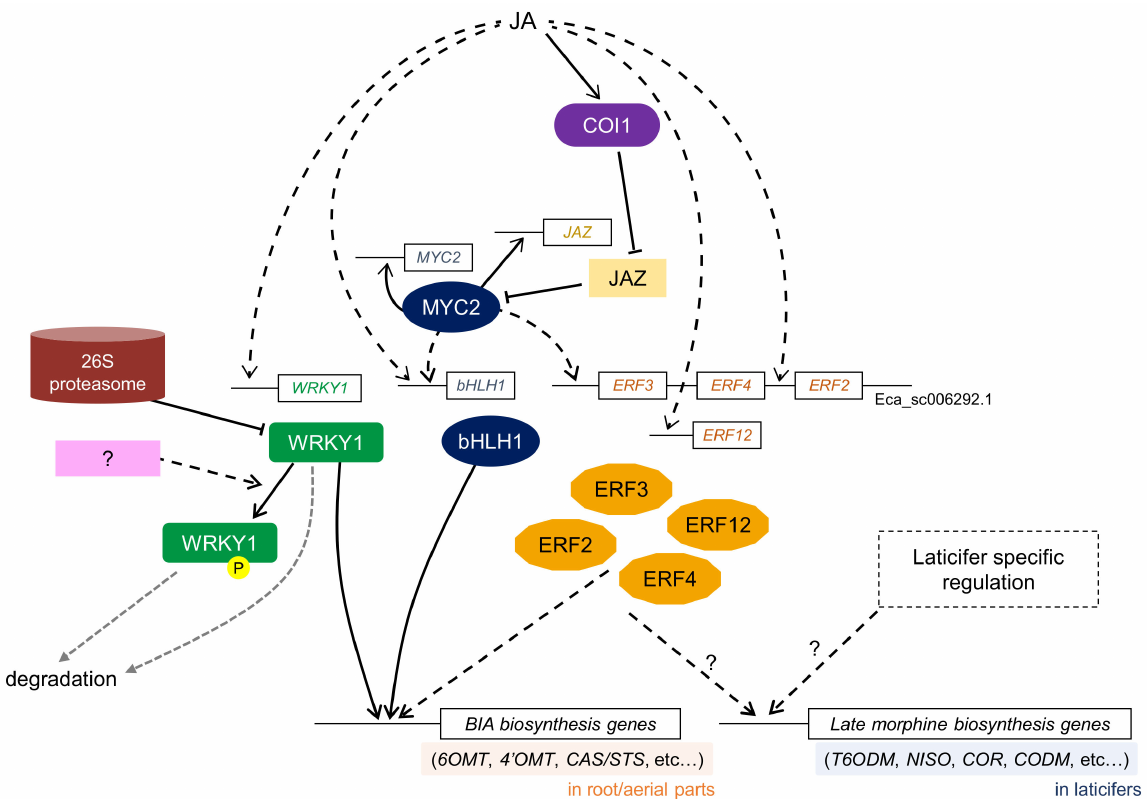
Figure 4. A simplified model of the transcriptional network of JA-signaling in BIA biosynthesis in C. japonica cultured cells and E. californica roots and cultured cells. Boxes with straight lines indicate regulator genes, including promoter regions. Black arrows and T-shaped lines indicate upregulation and inhibition, respectively. Broken lines show indirect or undetermined steps that are possibly involved in uncharacterized proteins or unidentified regulation. Gray dashed lines indicate degradation steps. Biosynthetic enzyme genes involved in late morphine pathway such as T6ODM , NISO , COR , and CODM might be controlled by laticifer-specific regulation, which remains to be determined. Since the functions of COI1, JAZ, and MYC2 proteins in BIA biosynthesis are not fully characterized, it is still unknown whether the expression of WRKY1 , bHLH1 , and several ERF genes is regulated by MYC2. Unphosphorylated WRKY1 is degraded by 26S proteasome, while unknown tyrosine kinase(s) and protease(s) might be involved in the phosphorylation and degradation of WRKY1, respectively, in C. japonica . BIA biosynthesis is regulated by several non-MYC2-type bHLH TFs (CjbHLH1 in C. japonica and EcbHLH1-1/2 in E. californica ), while only bHLH1 is described here. ERF2 , ERF3 , and ERF4 genes are clustered in the same E. californica genome scaffold, Eca_sc006292.1. Abbreviations: BIA, Benzylisoquinoline alkaloid; CAS/STS, ( S )- canadine synthase/( S )-stylopine synthase; CODM, Codeine O -demethylase; COR, Codeinone reductase; NISO, Neopinone isomerase; T6ODM, Thebaine 6- O -demethylase; 6OMT, ( S )-norcoclaurine 6- O -methyltransferase; 4’OMT, ( S )-3’-hydroxy- N - methylcoclaurine 4’- O